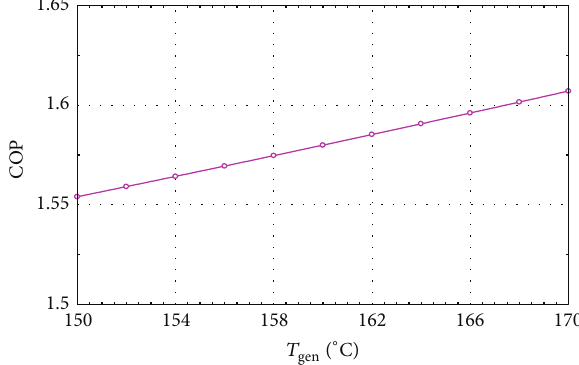
Figure 9: Variation with absorption generator temperature of ab- sorption chiller